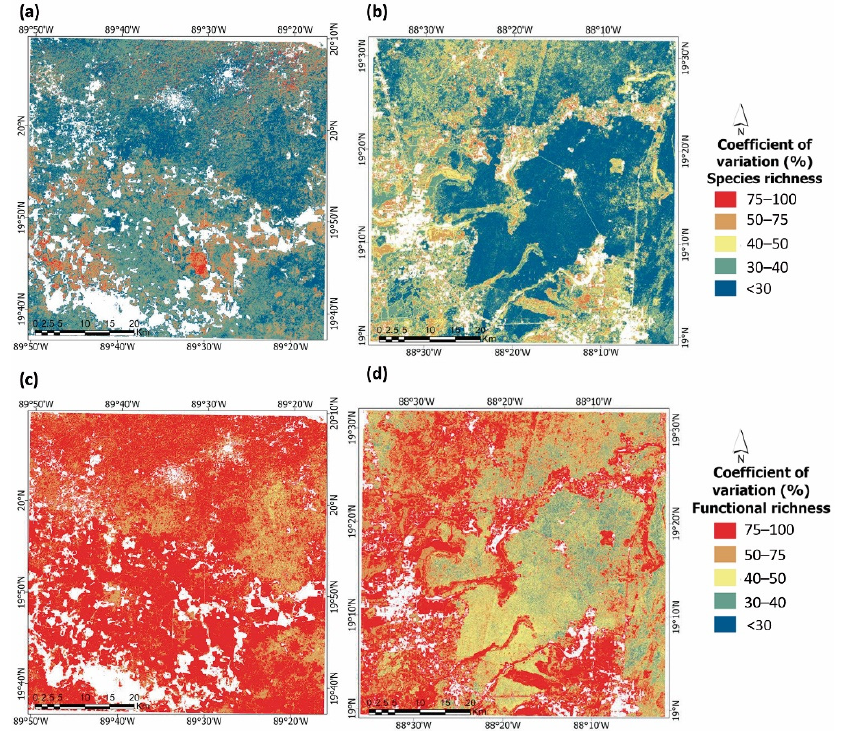
Figure 5. Uncertainty maps for tree species richness and functional richness for the tropical semi- deciduous forest (( a ) and ( b ), respectively) and tropical semi-evergreen forest (( c ) and ( d ), respec- tively). Blank areas correspond to non-forest cover (mostly cropland and human settlements).